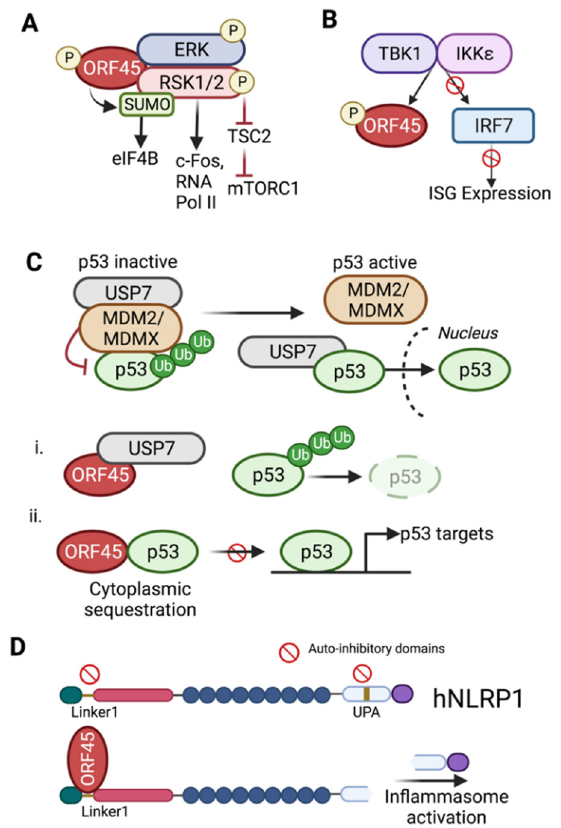
Figure 3. ORF45 interactions with host signaling pathways. ( A ) ORF45 sustains activation of the extracellular regulated kinase (ERK) p90 ribosomal s6 kinase (RSK) MAP kinase pathway by